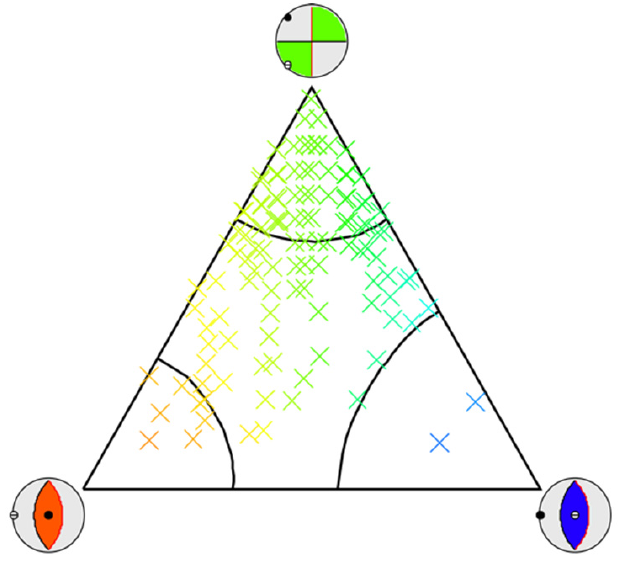
Figure 3. Focal mechanism solution classification diagram [32] of seismic activity in this study. The three vertices correspond to pure strike – slip (top, green), reverse (right, blue), and normal fault (left, orange) mechanisms. The curved lines on the figure correspond to the mechanisms having P and B axes with dips of 60° (left and top) and a T axis with a dip of 50° (right). Earthquakes are defined as normal, strike – slip, or reverse if the dip of the P or B axes exceeds 60° or if the dip of the T axis exceeds 50°, respectively [32]. 2.2. Stress Field Inversion Method The orientation of the fault plane and the direction of fault slip are determined by a set of seismic focal mechanisms, which can be used to calculate the most suitable principal